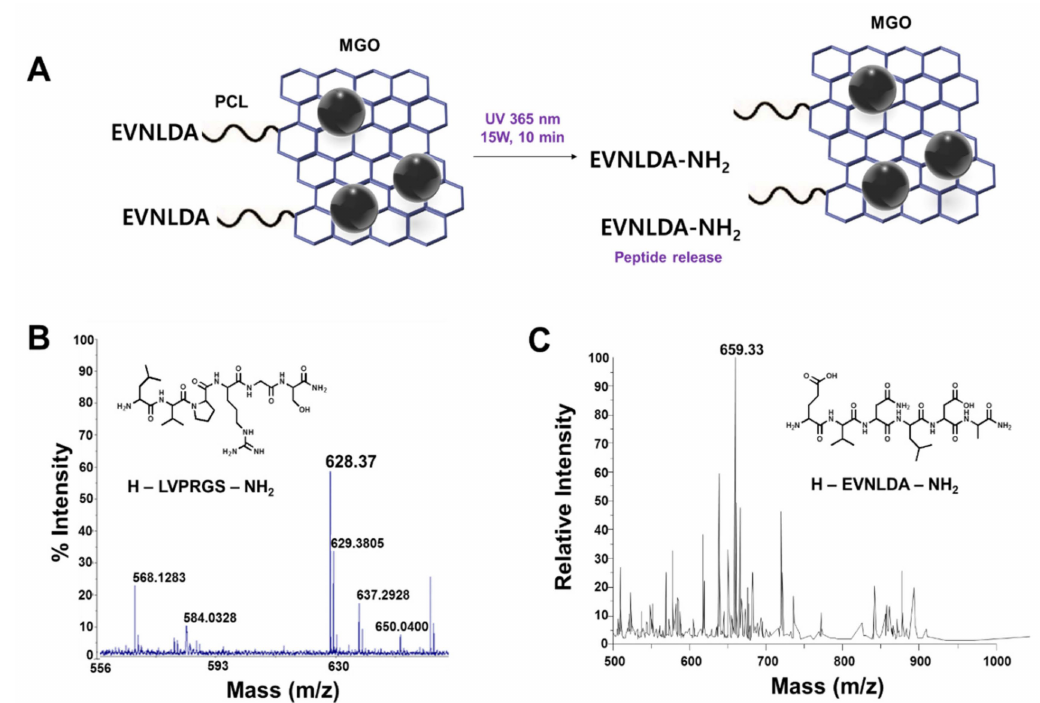
Figure 3. In situ peptide synthesis on MGO and mass spectrometry of the released peptides. ( A ) Schematic diagram of synthesized peptide on MGO and photocleavage reaction of β -secretase (EVNLDA) peptide on MGO. ( B , C ) MALDI-TOF analyses of H-thrombin(LVPRGS)-NH 2 and H-EVNLDA-NH 2 released from the MGO upon UV irradiation (365 nm).